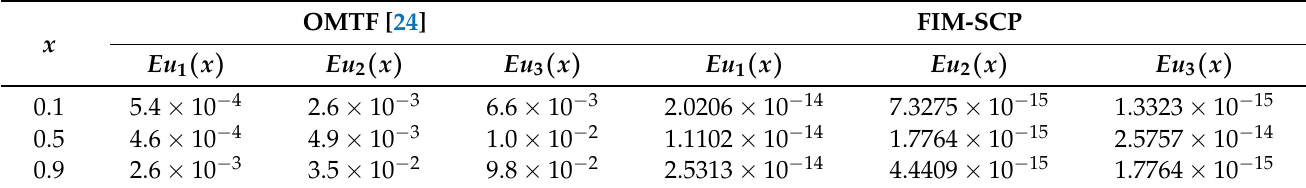
Table 5. Absolute errors of u 1 ( x ) , u 2 ( x ) and u 3 ( x ) at α 1 = α 2 = α 3 = 1 for Example 3.